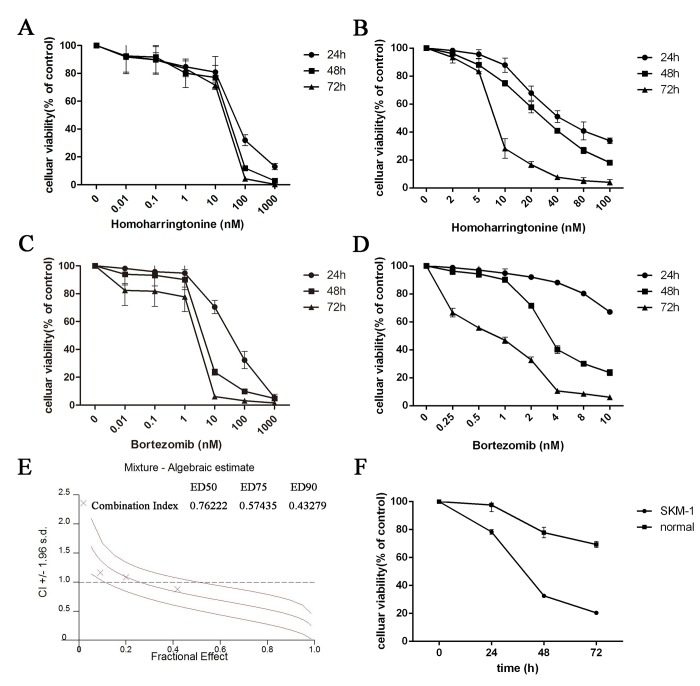
HHT and Bortezomib inhibited the cell viability of SKM-1 cells.(A) Time- and dose–response curves of HHT from 0.01 nM to 1000 nM. (B) Time- and dose–response curves of HHT from 2 nM to 100 nM. (C) Time- and dose–response curves of Bortezomib from 0.01 nM to 1000 nM. (D) Time- and dose–response curves of Bortezomib from 0.25 nM to 10 nM. (E) CI values for HHT and Bortezomib combination treatments at the molar ratio of 10.4:1. (F) Celluar viability of SKM-1 or normal PBMC cells simultaneously treated with 46.20 nM HHT and 4.46 nM Bortezomib.